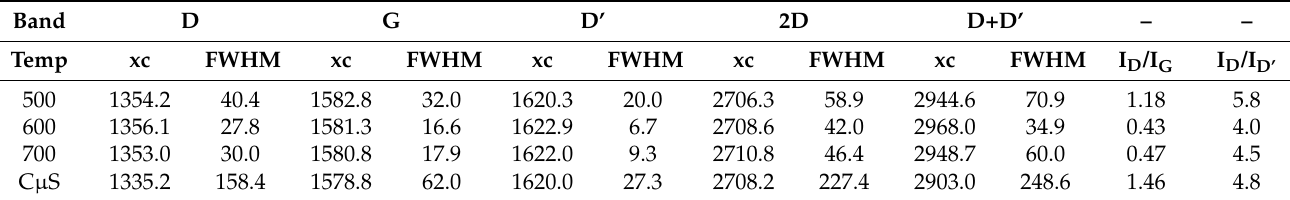
Table 1. Results of the Raman spectra